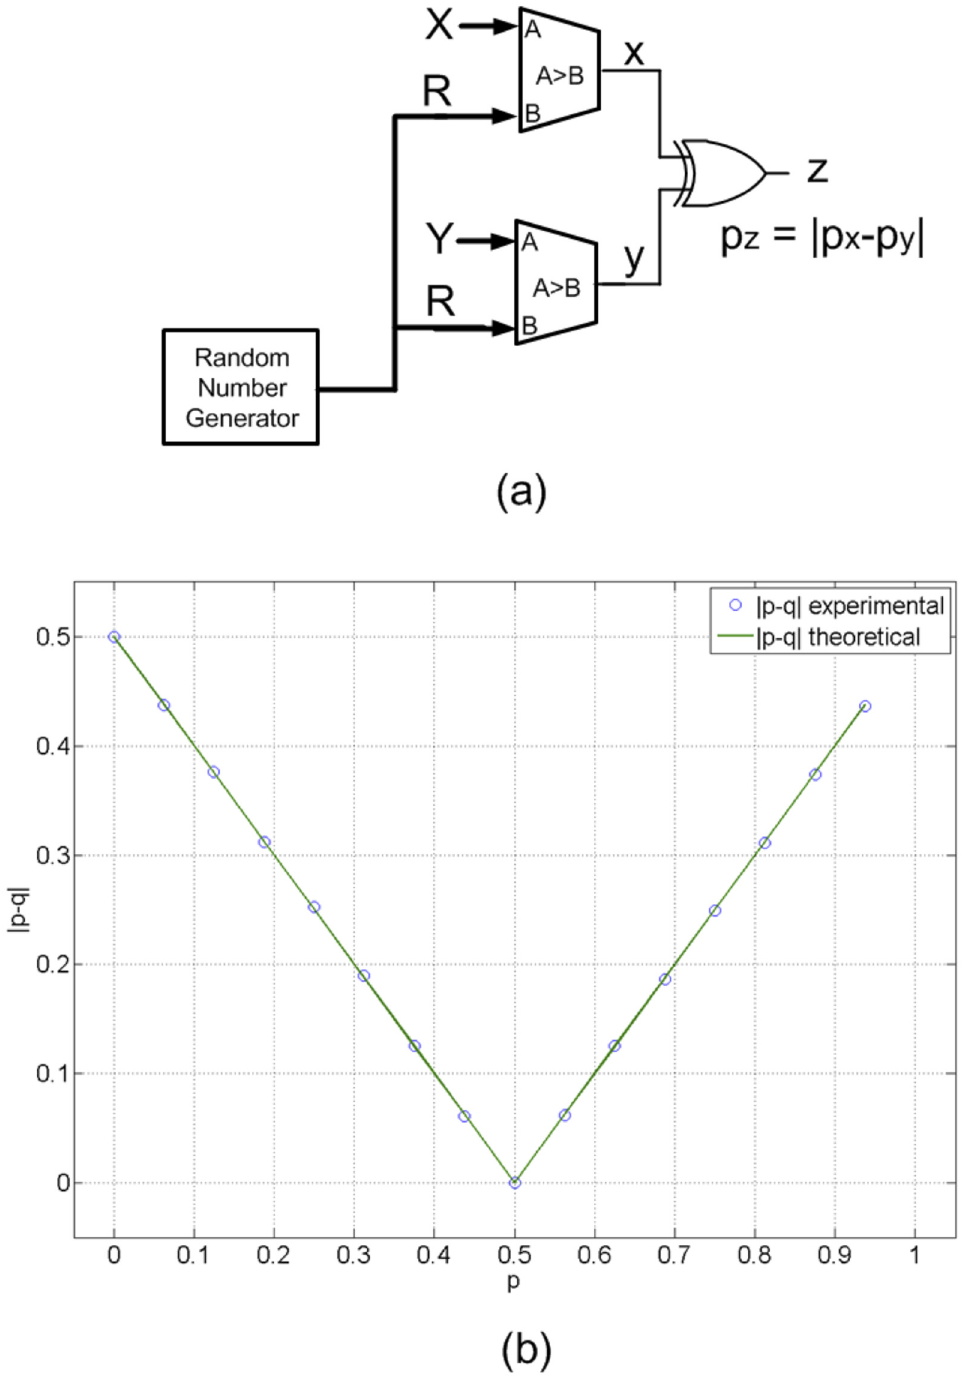
Fig 5. Similarity estimation of X and Y (with correlated signals). In contrast to the un-correlated scheme (case in which X and Y are compared with different random values), a non-linear function is obtained. The probability of the R signal of being between X and Y is proportional to |P x -P y | that is the switching activity of the output signal. (a) Probabilistic circuitry for the computation of |P x -P y |. (b) Experimental results when evaluating |P x -P y |.